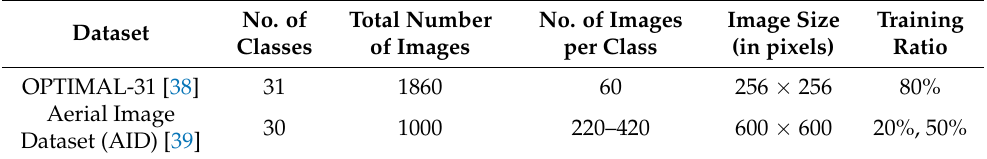
Table 1. Characteristics of the two RS image scene classification datasets used in this